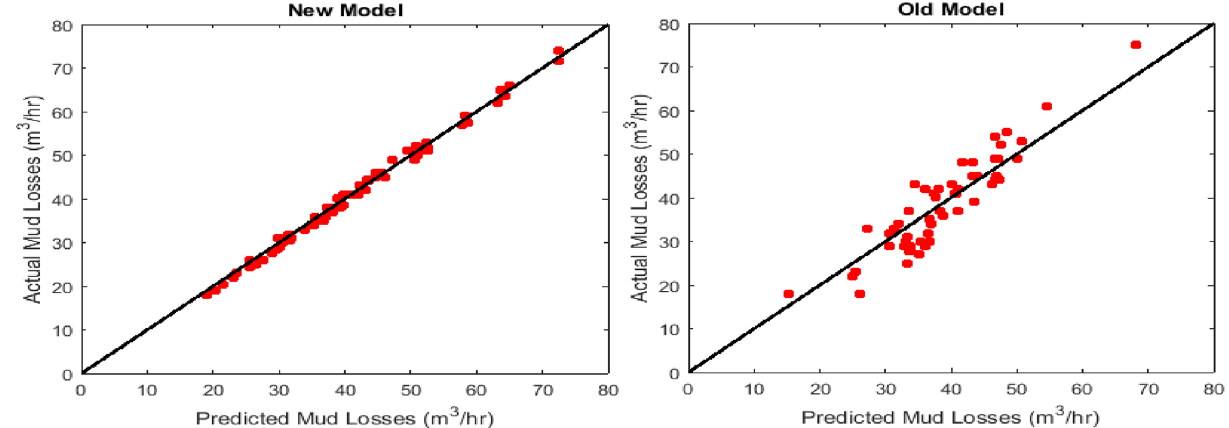
Fig. 33 Predicted versus actual mud loss for severe and complete losses